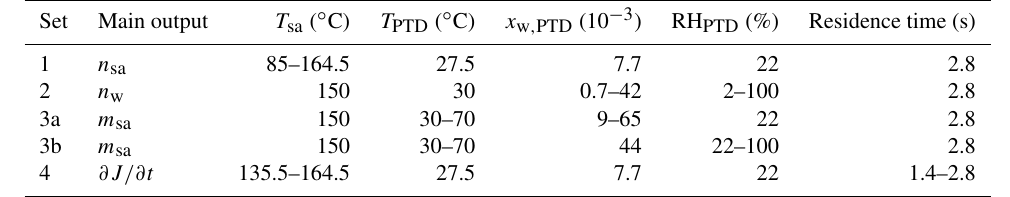
Table 1. The varied conditions of the measurement points.